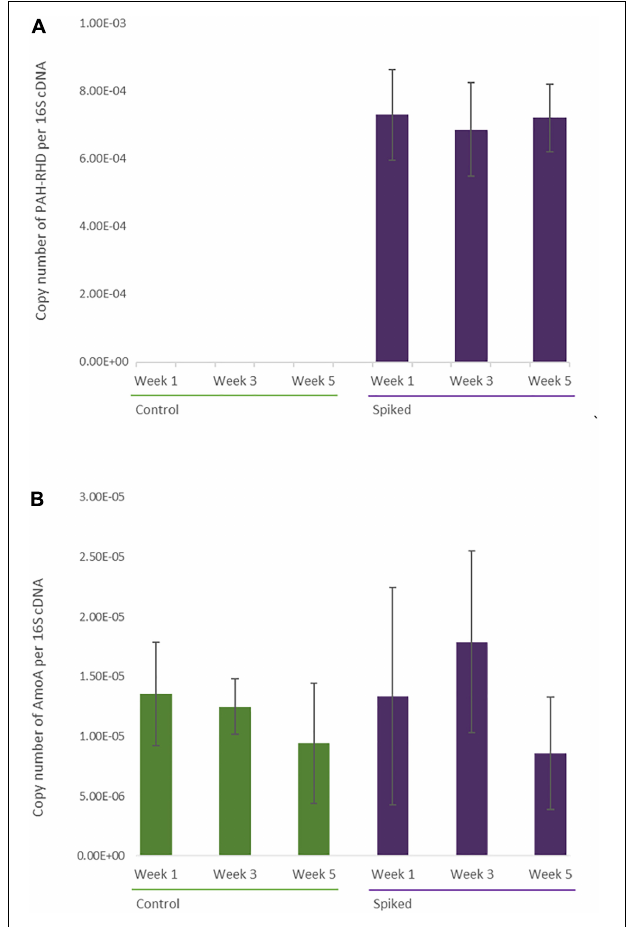
FIGURE 7 | RT-qPCR Quantification of PAH-RHD (A) and AmoA cDNA gene copies (B) . Relative abundance of PAH-RHD and AmoA copies were normalized by 16S gene copy count and averaged per treatment and timepoint. Error bars represent standard deviation from replicates.